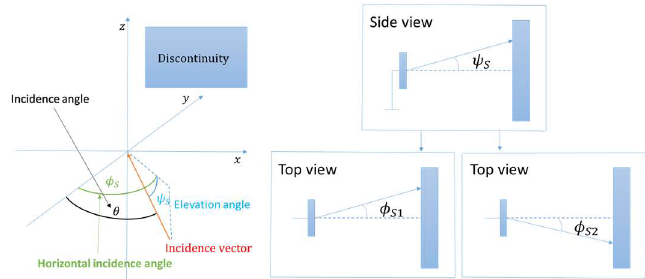
Figure 6. Horizontal incidence angle, φ S , elevation angle, ψ s , and incidence angle, θ , of a single ray (left) and example of two sample rays (right) having the same elevation angle, ψ s , and different azimuth angles, φ S 1 and φ S 2